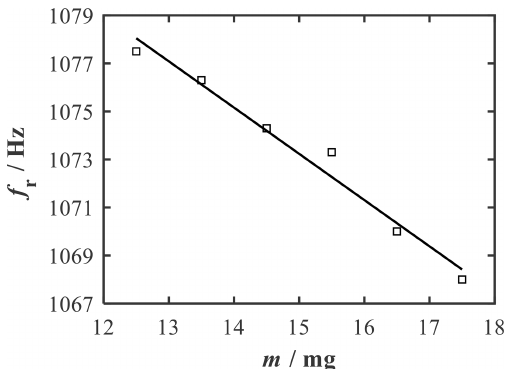
Figure 7. Resonant frequency depending on the sample mass from